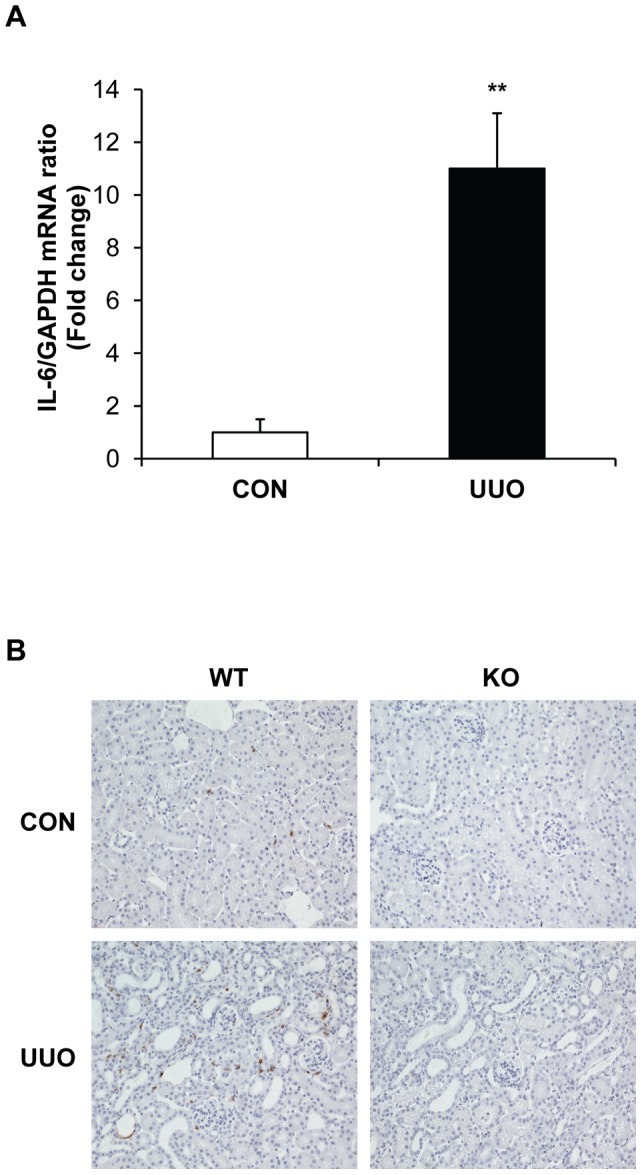
IL-6 is induced in the kidney following obstructive injury.
A. Graphic presentation shows IL-6 mRNA induction. ** P<0.01 vs normal control kidney. n = 4. B. Representative photomicrographs of kidney sections stained for IL-6 (brown) and counter stained with hematoxylin (blue) (Original magnification: X400).